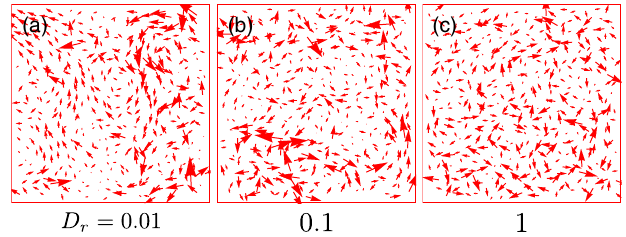
FIG. 4. (a) – (c) Instantaneous cell displacements at p 0 ¼ 3 . 65 and v 0 ¼ 0 . 5 . They are different from the displacements shown in Fig. 1(d), which are averaged over the structural relaxation time 0 . 01 , the cells are able to scale. (a) At the lowest value of D r ¼ flow by collectively displacing along the “ soft ” modes of the 0 . 1 , collective displace- system (Appendix B 1). (b) At D r ¼ 1 and larger, the ments are less pronounced. (c) For D r ¼ displacements appear disordered and